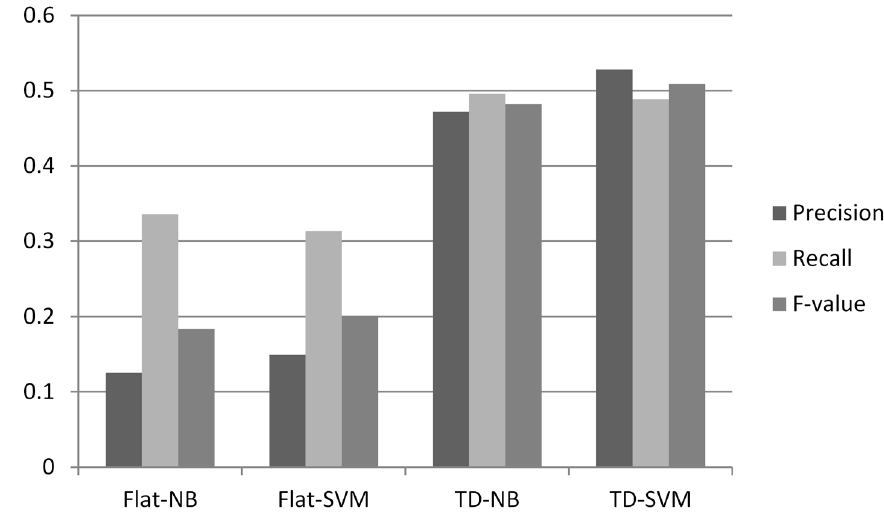
Figure 4. Performance of different experimental settings.